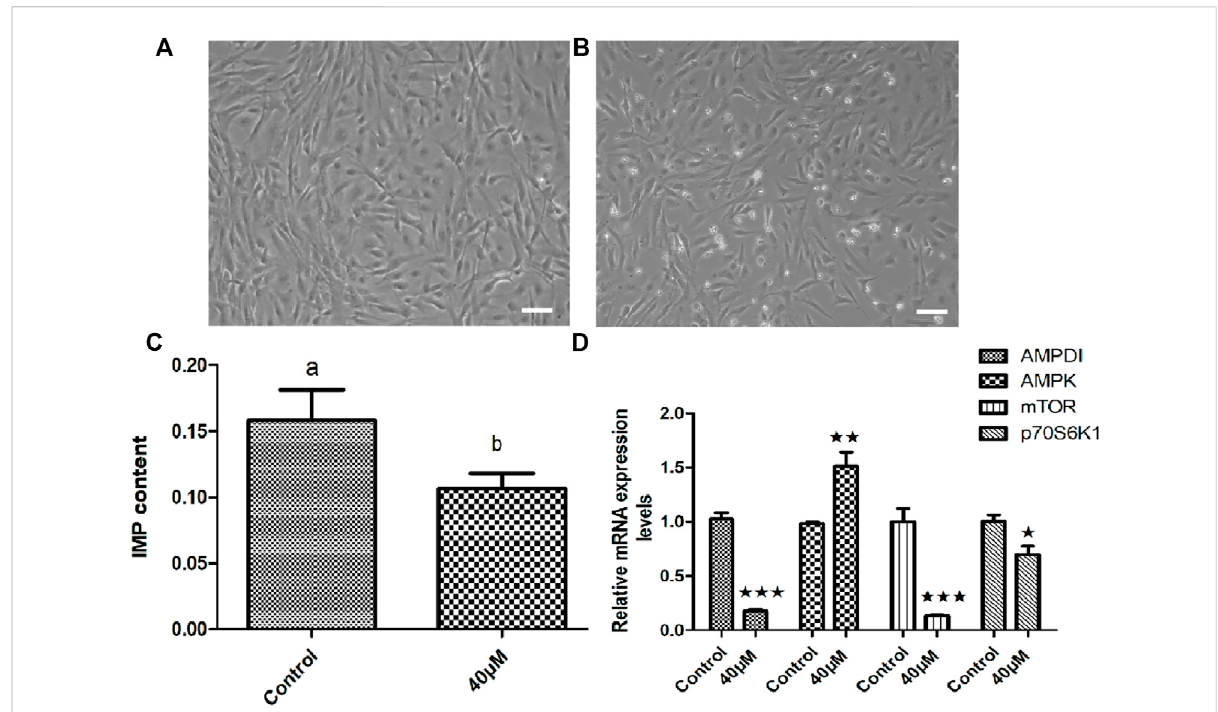
FIGURE 7 Effects of 40 μ M AMPD1 inhibitor on the IMP content and AMPK-mTOR signaling pathway related genes in vitro . (A) the sixth generation of musclecells, (B) thesixthgenerationofmusclecellstreatedwith40 μ Minhibitorfor16 h,bar=100 μ m, (C) thedetectiondiagramofIMPcontentby HPLC; (D) the effects on the expression of AMPK-mTOR signaling pathway related genes. Error bars represent the means ± SD; n = 3. p <